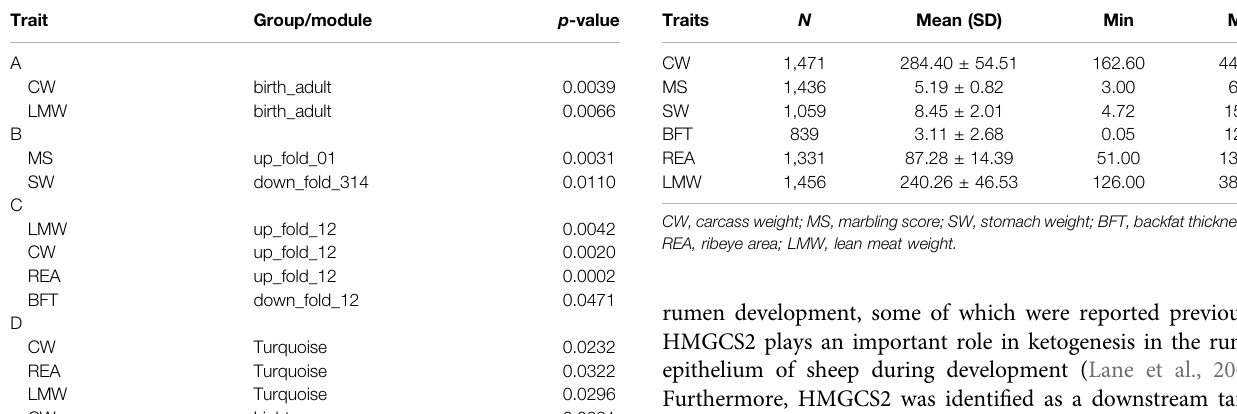
TABLE 5 | Statistical description of six traits in Chinese Simmental beef